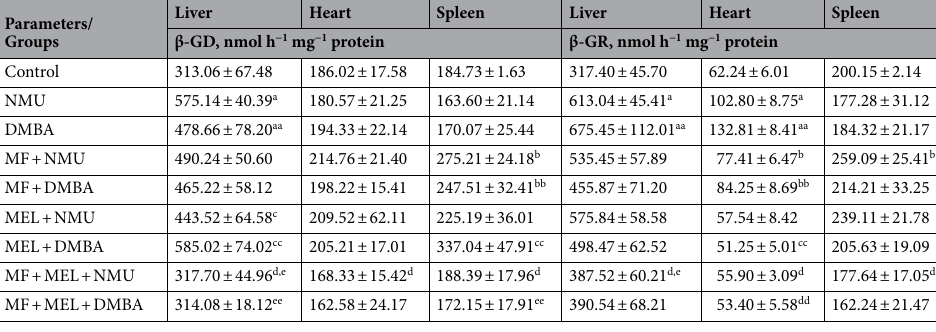
Table 3. Effect of melatonin and metformin on β-glucuronidase and β-galactosidase activity (nM/h/ mg protein) in the liver, heart and spleen in female Sprague-Dawley rats subjected to a high-fat diet in the mammary carcinogenesis model induced by N -methyl- N -nitrosourea (NMU) or dimethylbenzanthracene (DMBA). Metformin (MF) or melatonin (MEL) was administered alone and in combination (MF + MEL). Note. Data are expressed as means ± S.D. Significant differences P < 0.05 are designated as follows: a— NMU group vs. control group; aa—DMBA group vs. control group; b—MF + NMU vs. NMU